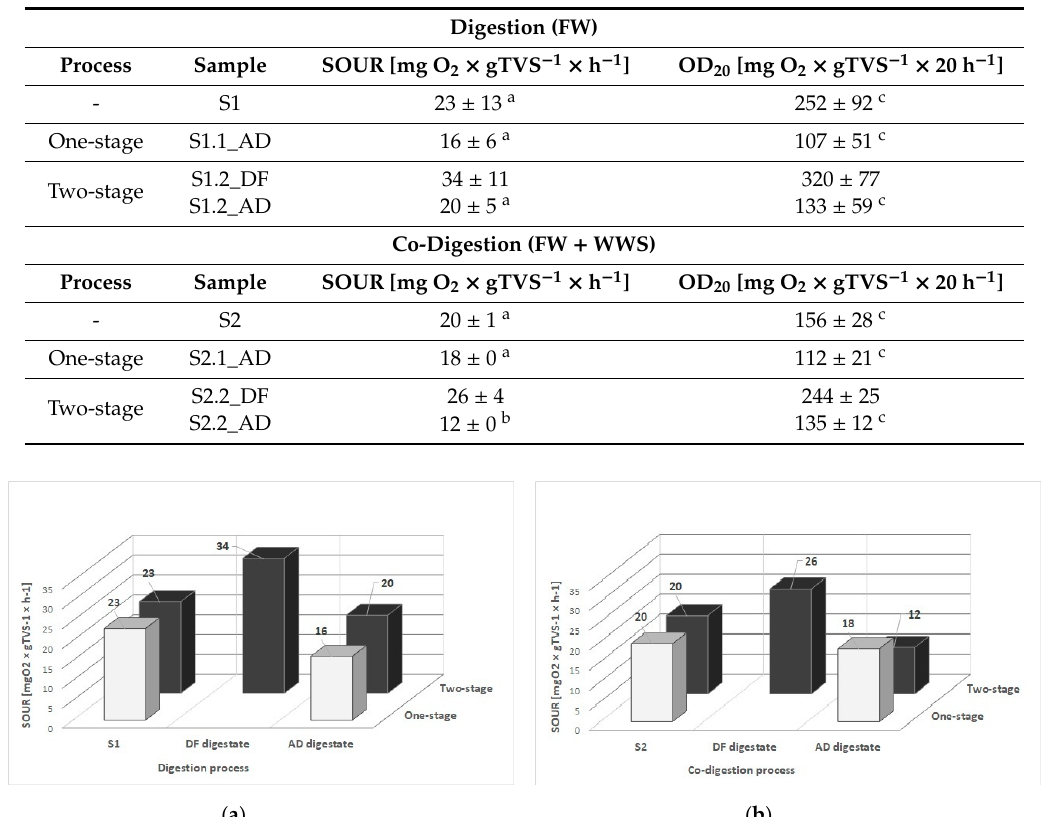
Table 3. Specific oxygen uptake rate (SOUR) and OD 20 indexes. Results are reported as averages and standard deviation (n = 2). The apex letters indicate the result of the statistical analysis performed with Welch t -test (values are not statistically di ff erent when p > 0.05). The same letters indicate that the populations are not statistically di ff erent.